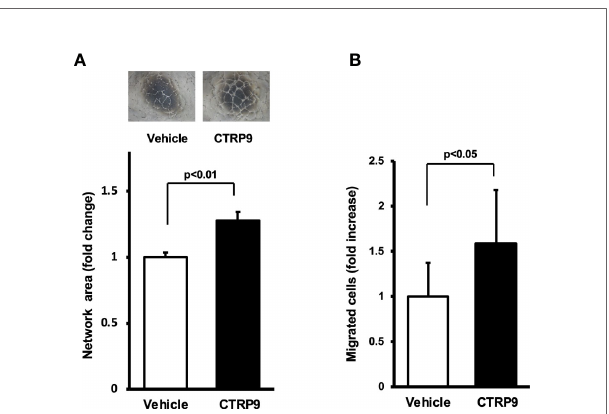
FIGURE 3 | CTRP9 promotes network formation and migration of cultured endothelial cells. (A) Endothelial cell network formation after stimulation with CTRP9 or vehicle. After 24 h of serum deprivation, human umbilical vein endothelial cells (HUVECs) were treated with recombinant CTRP9 (10 m g/ml), or PBS (control) followed by culture in Matrigel-coated dishes. Representative photomicrographs of HUVEC network formation is shown (upper panel). Quantitative analyses of the network area of tubes are shown (lower panel) (n = 3 independent culture experiments). (B) Endothelial cell migration after stimulation with CTRP9 or vehicle. A modi fi ed Boyden chamber assay was performed using HUVECs. HUVECs were treated with CTRP9 (10 µg/ml), or PBS (control). Results are presented as mean ± SD. Results are expressed relative to the values compared with control (n = 8 independent